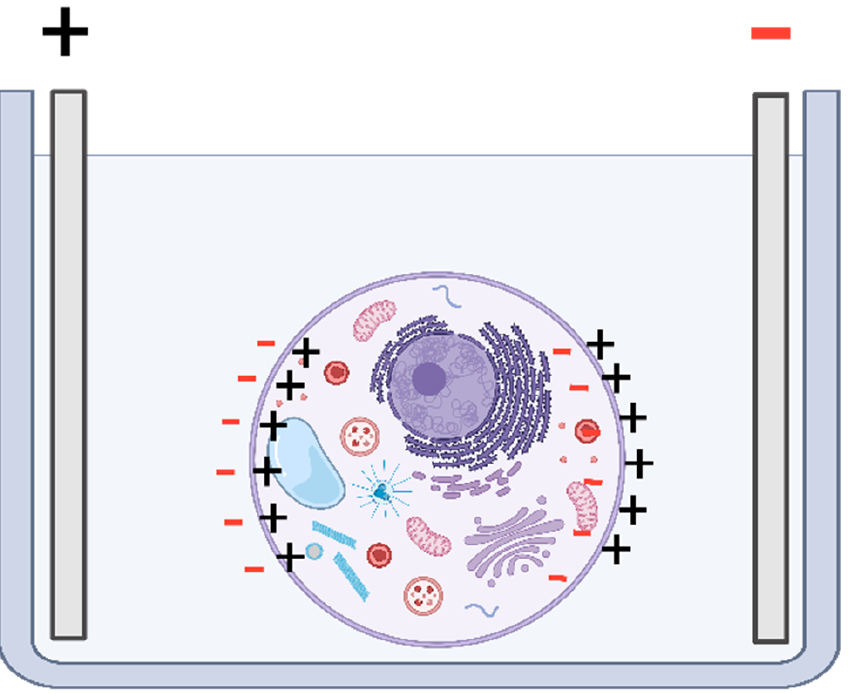
Figure 8 . Increased trans-membrane potential due to the application of external electric field.